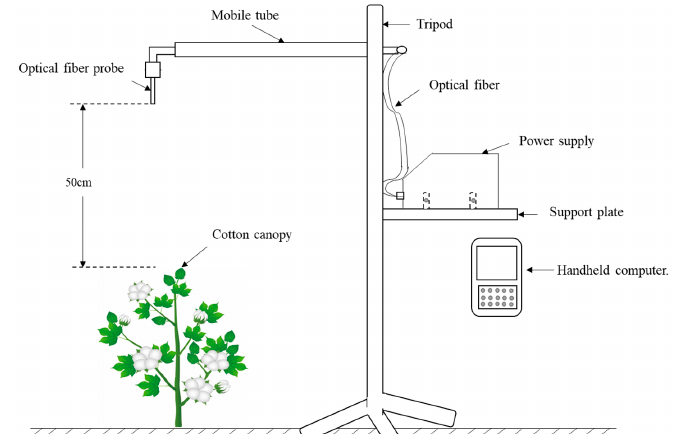
Figure 1. The spectrum acquisition device